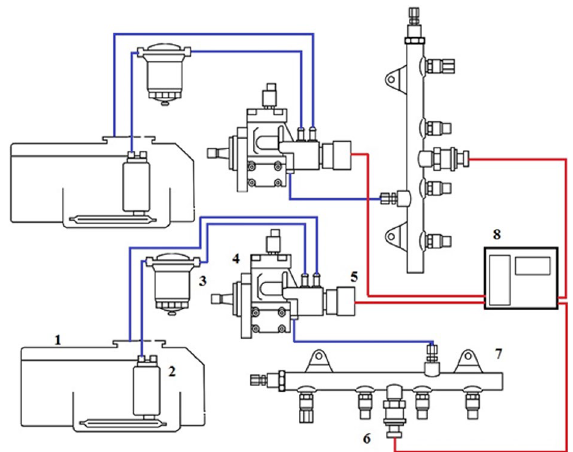
Fig. 1. Experimental test bed scheme: 1 – fuel tank; 2 – fuel transfer pump; 3 – fuel filter; 4 – high pressure pump; 5 – fuel (rail) pressure regulator; 6 – fuel pressure sensor; 7 –common rail; 8 – fuel pressure control